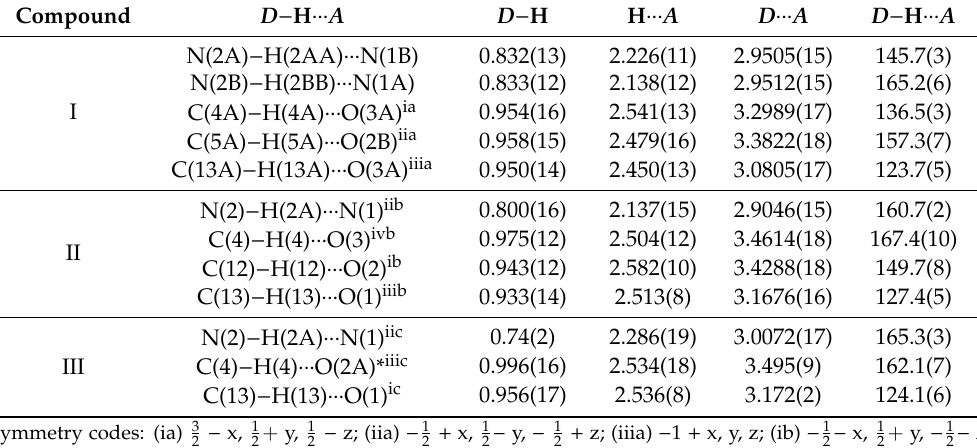
Table 3. Hydrogen-bond geometry (Å, º) for I, II and III.